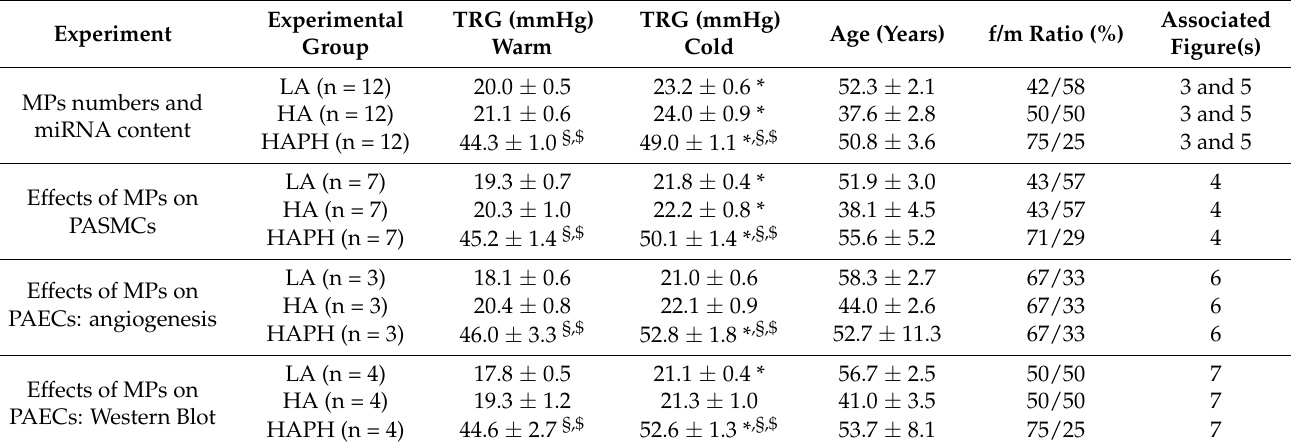
Table 1. Echocardiography-derived tricuspid regurgitant systolic pressure gradient (TRG) and demographic profiles in Kyrgyz